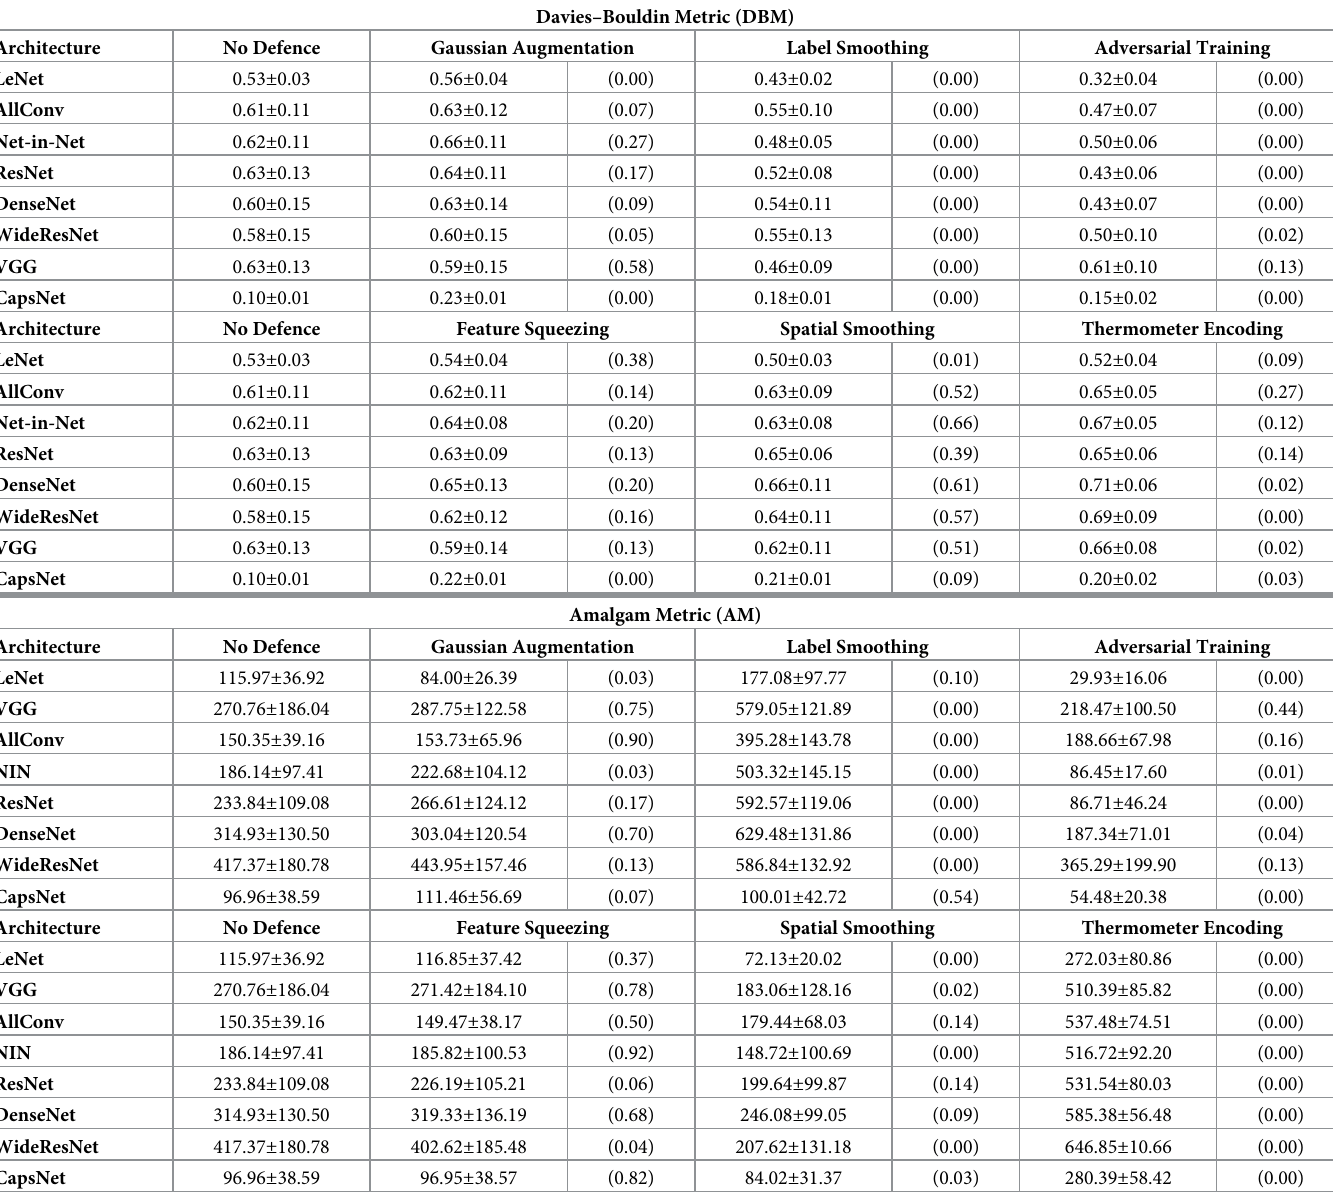
Table 2. Mean and standard deviation of Davies–Bouldin Metric (DBM) and Amalgam Metric (AM) values for different Raw Zero-Shot Classifiers with and without the adversarial defences on CIFAR-10. Davies–Bouldin Metric